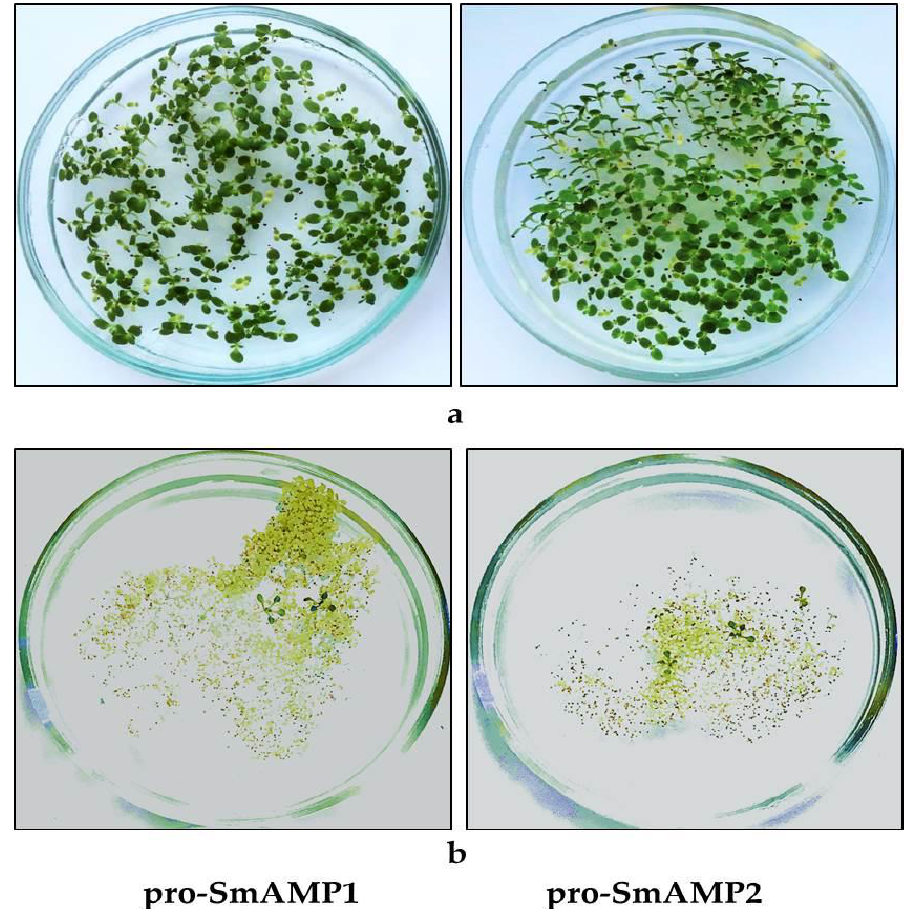
Figure 4. Segregation of T 1 seedlings on selective medium containing kanamycin. ( a ) Progeny of primary tobacco transformants expressing nptII from the pro-SmAMP1 (102) and pro-SmAMP2 (104) promoters. ( b ) Primary Arabidopsis transformants after Agrobacterium -mediated transformation with pro-SmAMP1 :nptII and pro-SmAMP2 :nptII promoter variants, − 170 and − 172 bp from the TSS, respectively.